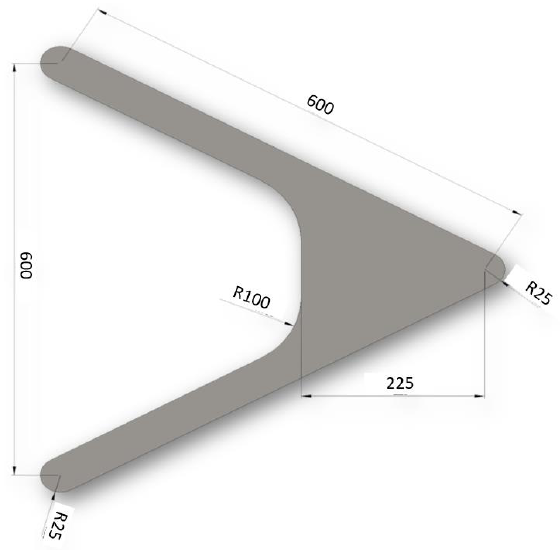
Figure 9. Initial prismatic design of the Delta VLFS.